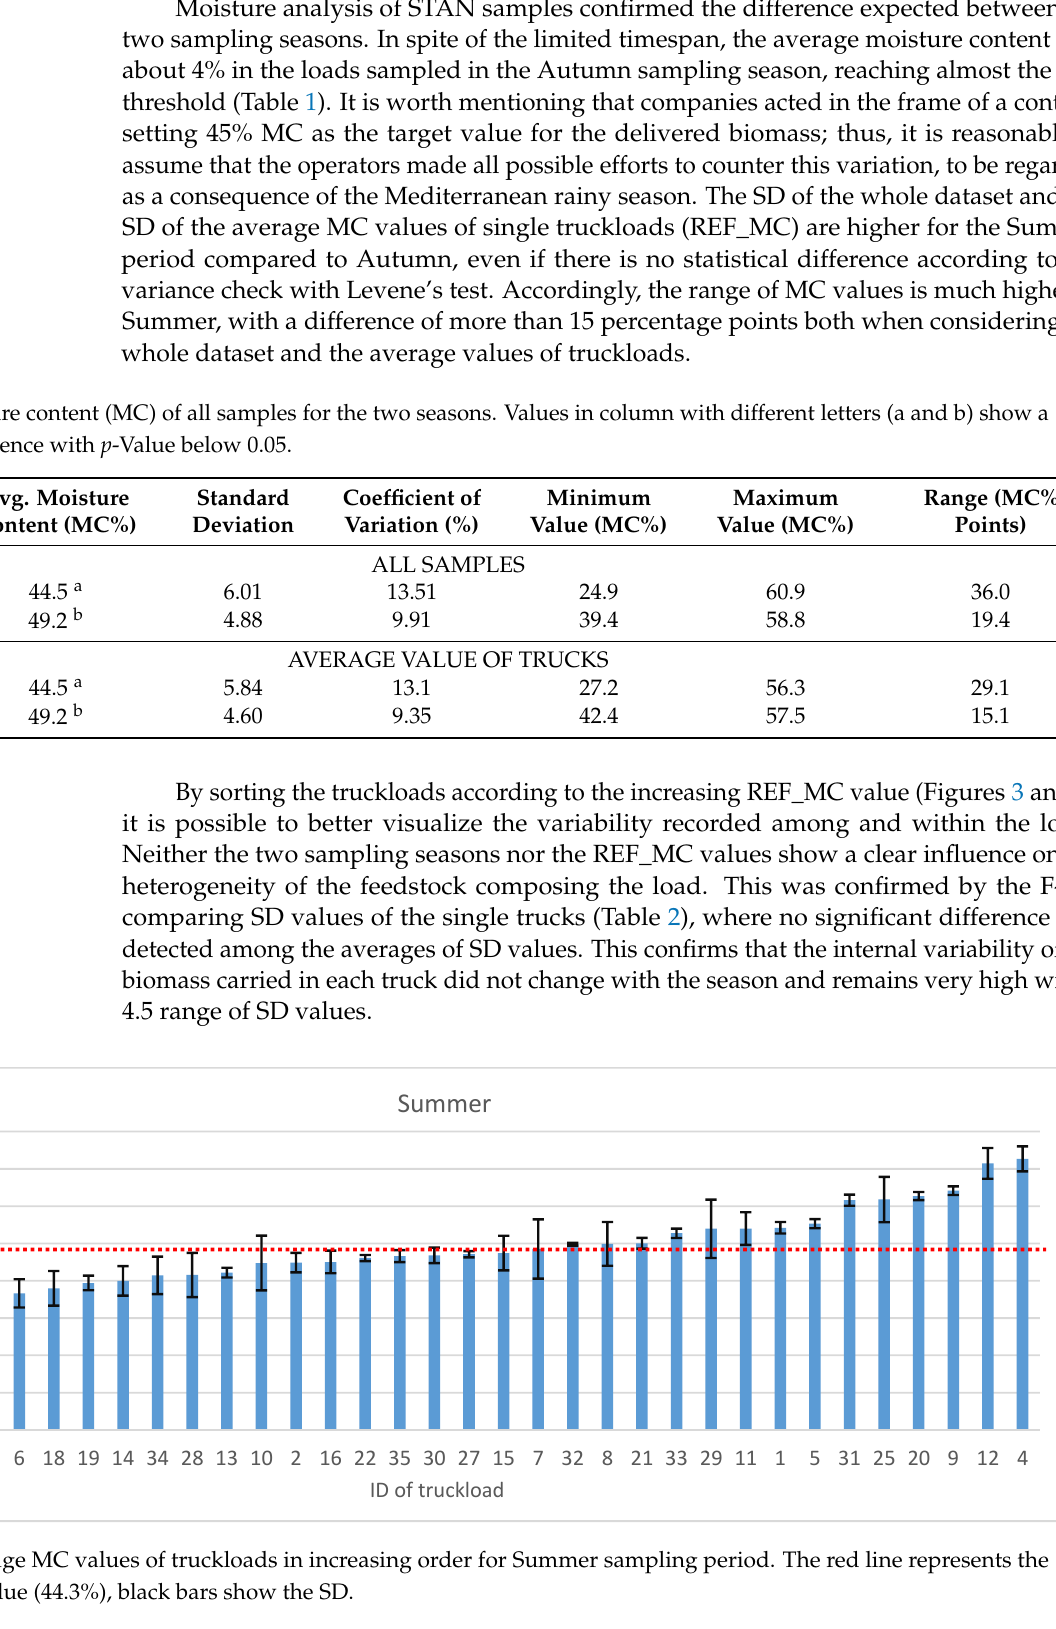
Figure 4. Average MC values of truckloads in increasing order for Autumn sampling period. The red line represents the average MC value (49.2%), black bars show the SD. Table 2. Analysis of the SD values of each trucks (relative to the 5 samples measured in each truck).